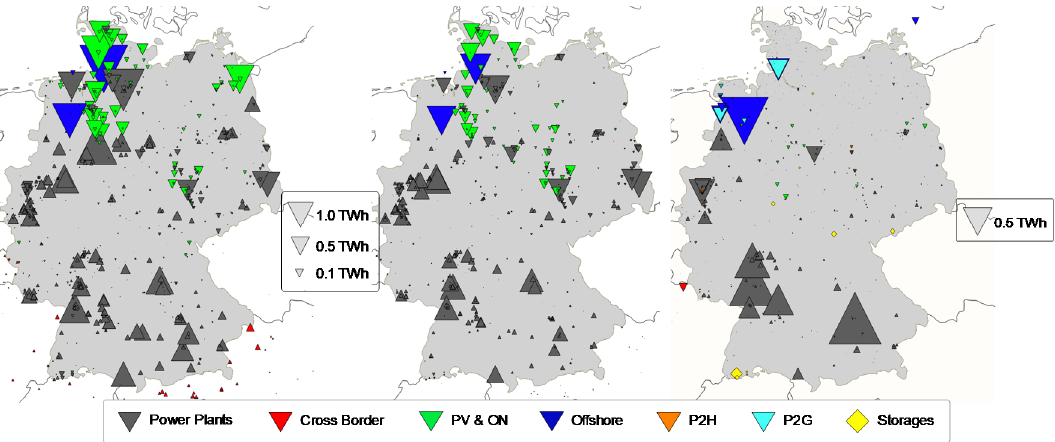
Figure 10. Spatially resolved congestion management measures for grid expansion scenario 2023 ( left ), scenario 2023+ ( center ), and scenario 2035 ( right ); upward/downward pointing triangles indicate a power increase/decrease.